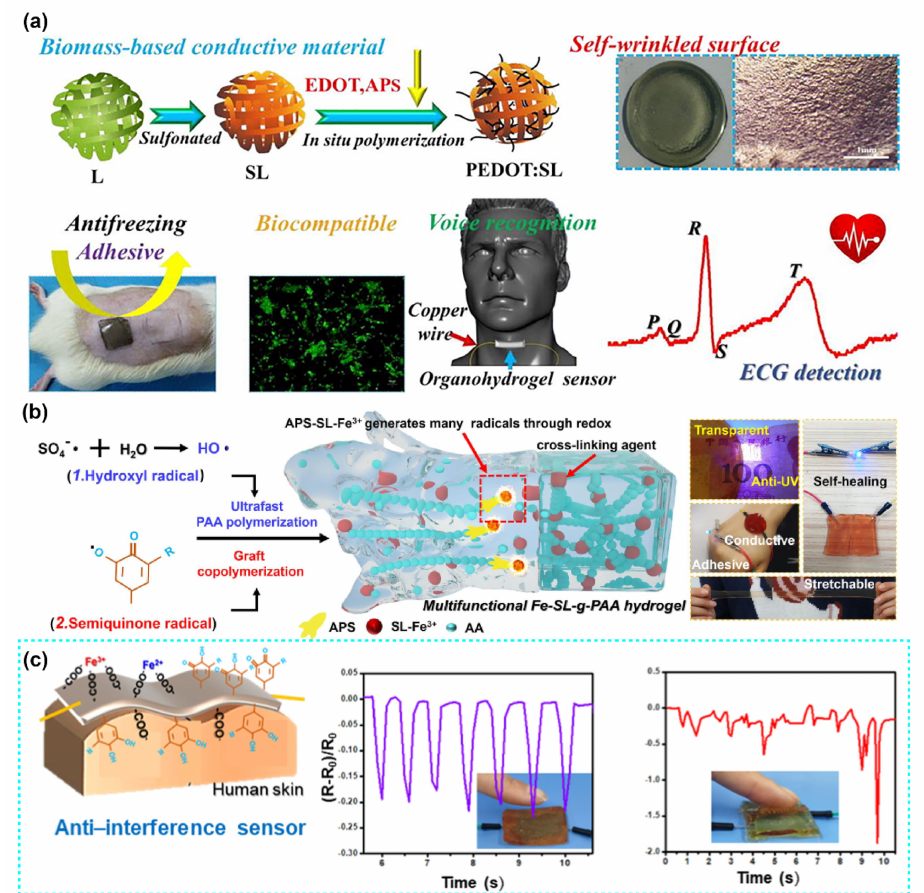
Figure 4. ( a ) Schematic for the PEDOT:SL-PAA organohydrogel synthesis, properties, and applica- tions. Reproduced with permission from ref. [54]. Copyright 2019, Elsevier. ( b ) Schematic illustration of various free radical-initiated fast monomer polymerization and multifunctional hydrogels formed by SL/metal ion chelate crosslinked polymer chains. Reproduced with permission from ref. [73]. Copyright 2020, Elsevier. ( c ) Pressure sensors are assembled from asymmetrically bonded hydrogels. Pressure signals were recorded by Fe 3+ -treated P(AA-co-LS) and pristine P(AA-co-LS) hydrogel pressure sensors. Reproduced with permission from ref. [75]. Copyright 2021,